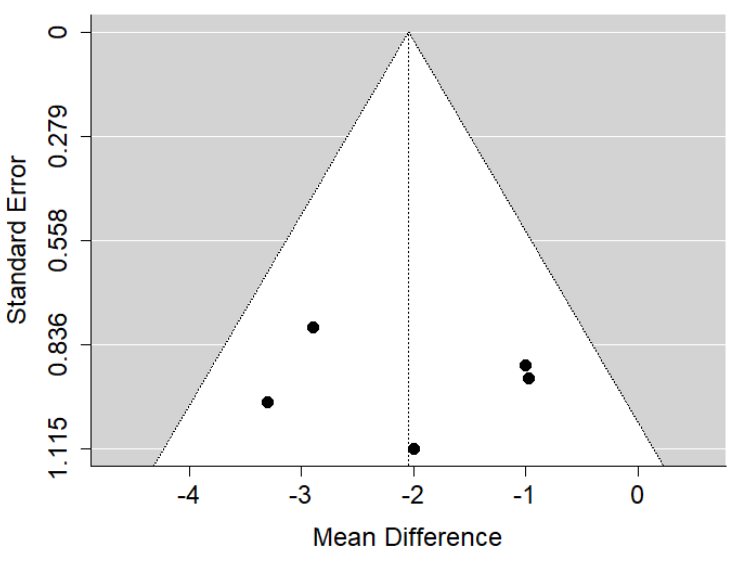
Figure 7. Funnel plot of SNA values for the comparison of patients with untreated cleft palate only vs. non-cleft healthy population [18,34,35].